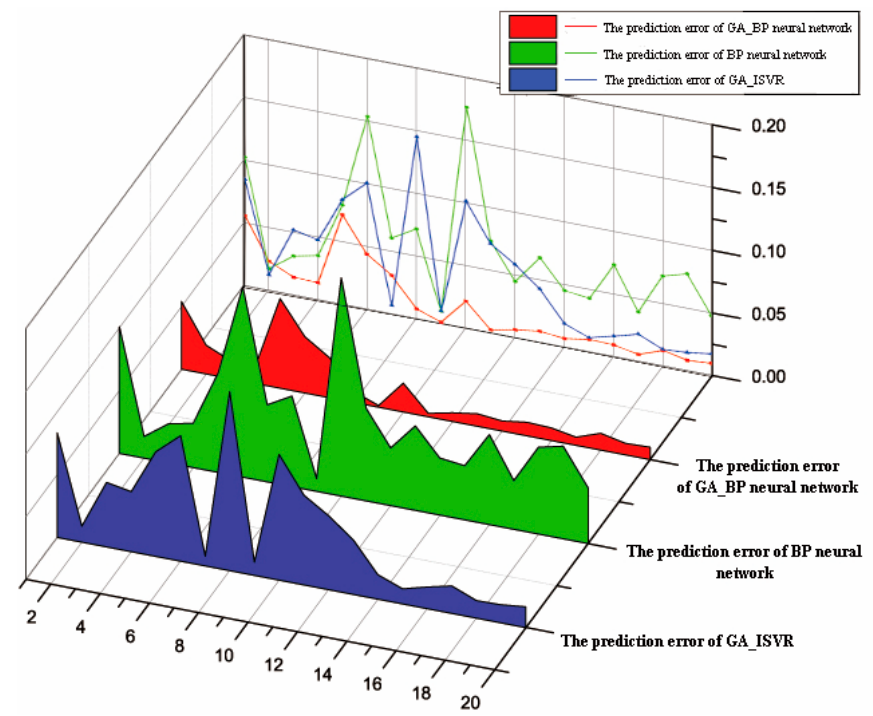
Figure 16. Schematic diagram of comparison between underbreak errors.